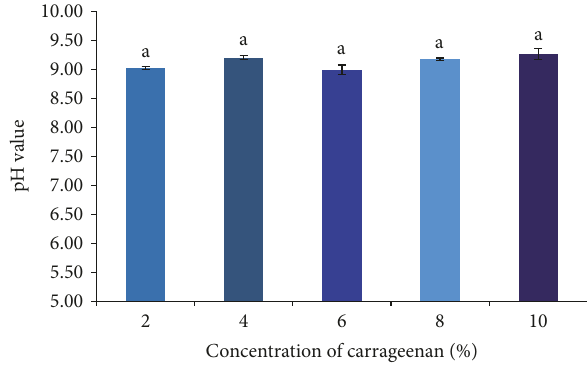
Figure 1: pH profiles of different carrageenan concentrations ranging from 2 to 10. The experiments were carried out in triplicate ( 𝑛 = 3 ). Similar alphabet shows insignificant difference ( 𝑝 > 0.05 ) between samples.